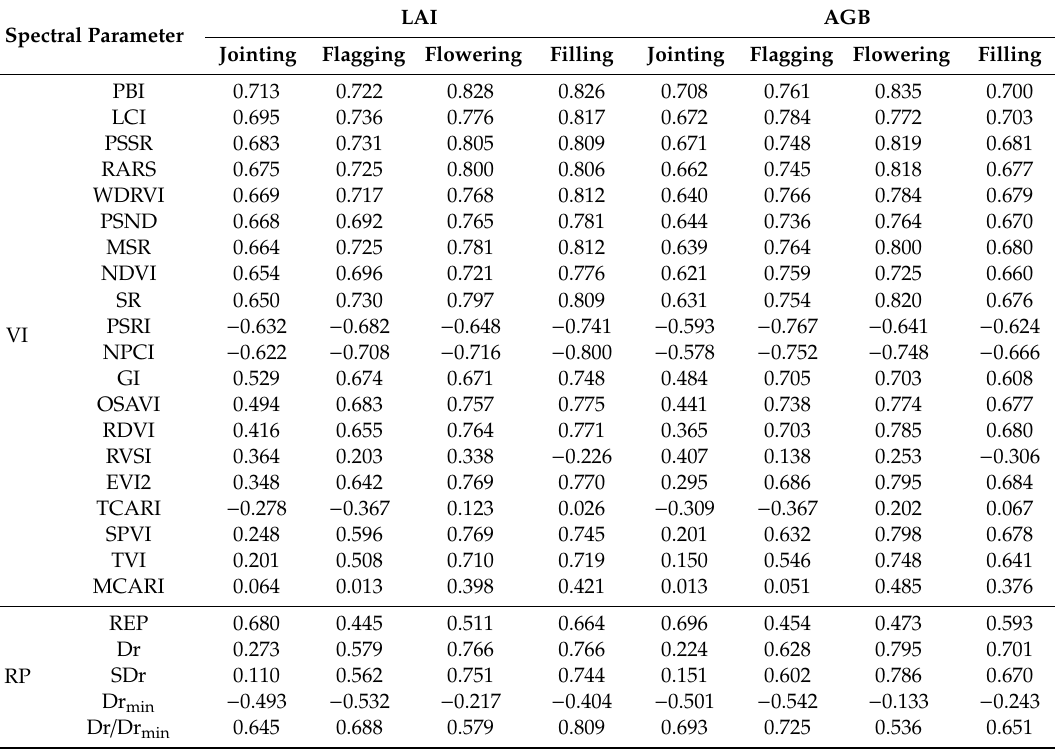
Table 3. Correlation coe ffi cients between crop growth parameters (the above-ground biomass [AGB] and leaf area index [LAe metrics for the estimates of winter-wheat growth parameters (AGB I]) and vegetation indices and red-edge parameters (RPs) for the four growth stages of winter wheat. LAI AGB Spectral Parameter Jointing Flagging Flowering Filling Jointing Flagging Flowering